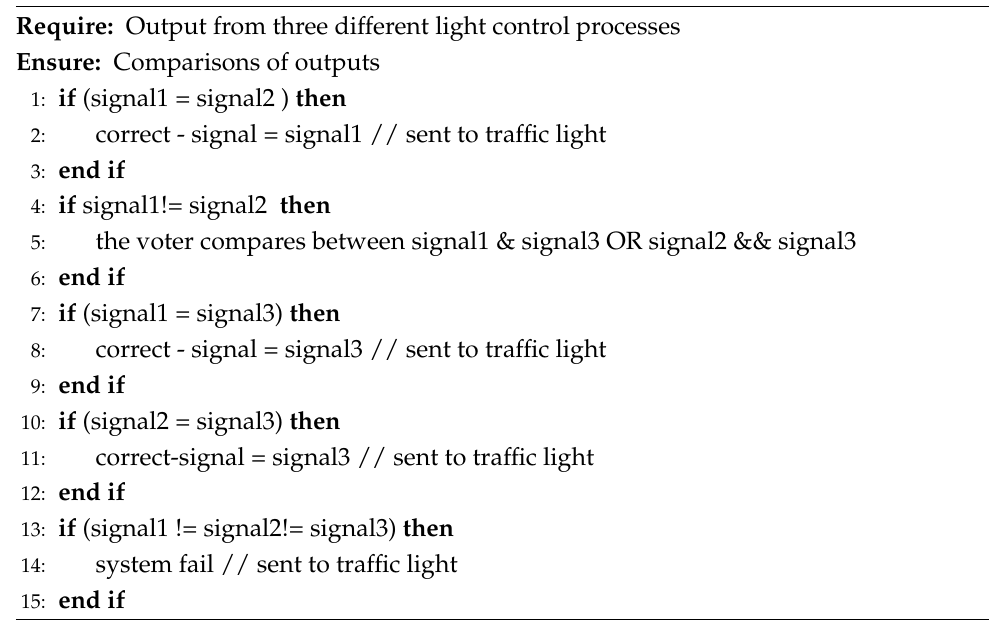
Algorithm 3 Comparing light controller process